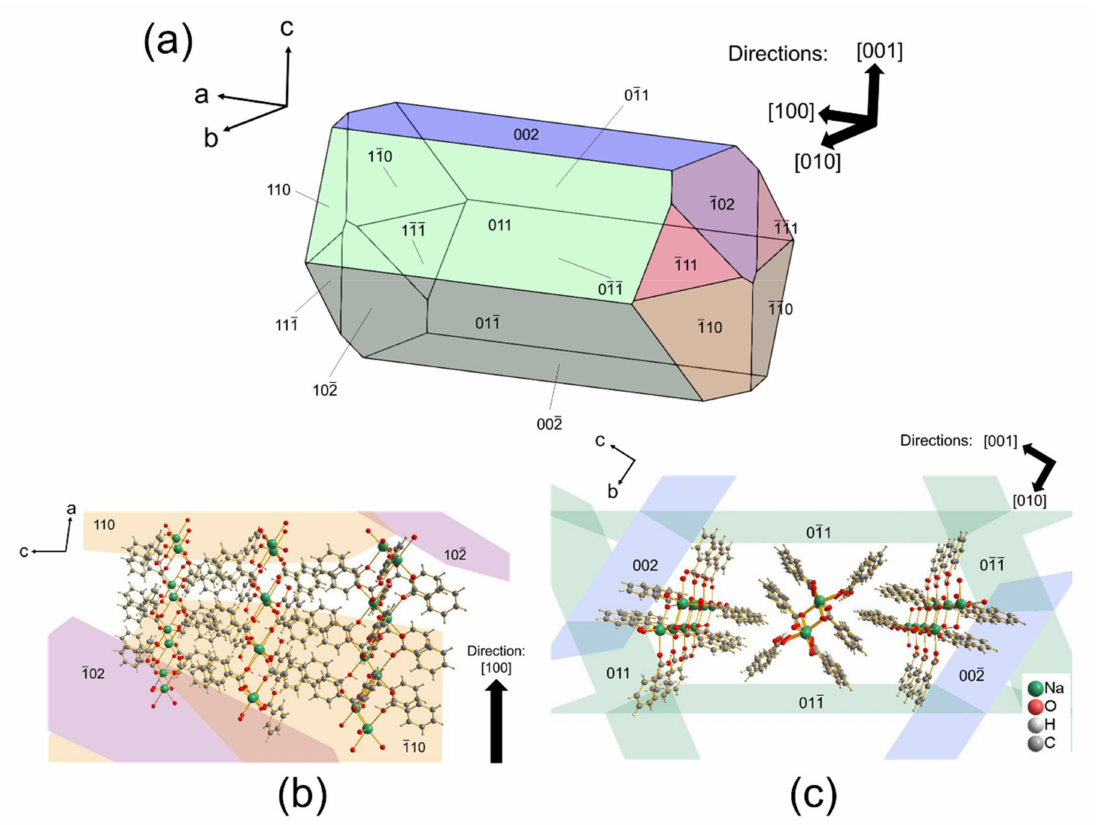
Figure 8. ( a ) Theoretical morphology of 2:1 HBz–NaBz co-crystal by BFDH method and theoretical molecular packing of 2:1 HBz–NaBz co-crystal in Form A, drawn together with the faces viewed along ( b ) b -axis and ( c ) a